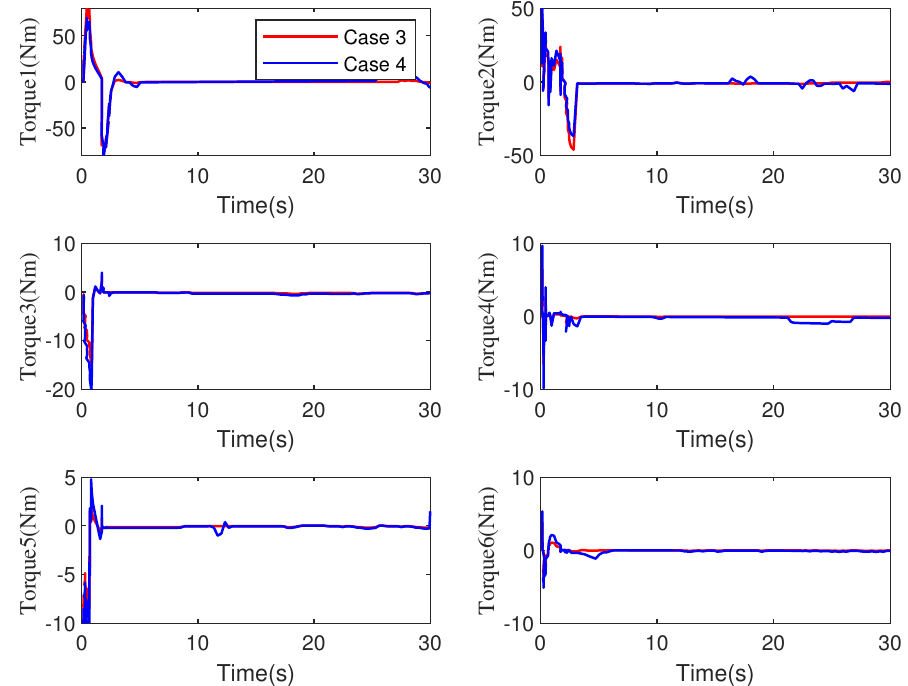
Figure 16. Torque of the 6-DOF robot manipulator with time-varying external disturbances in Case 3 and Case